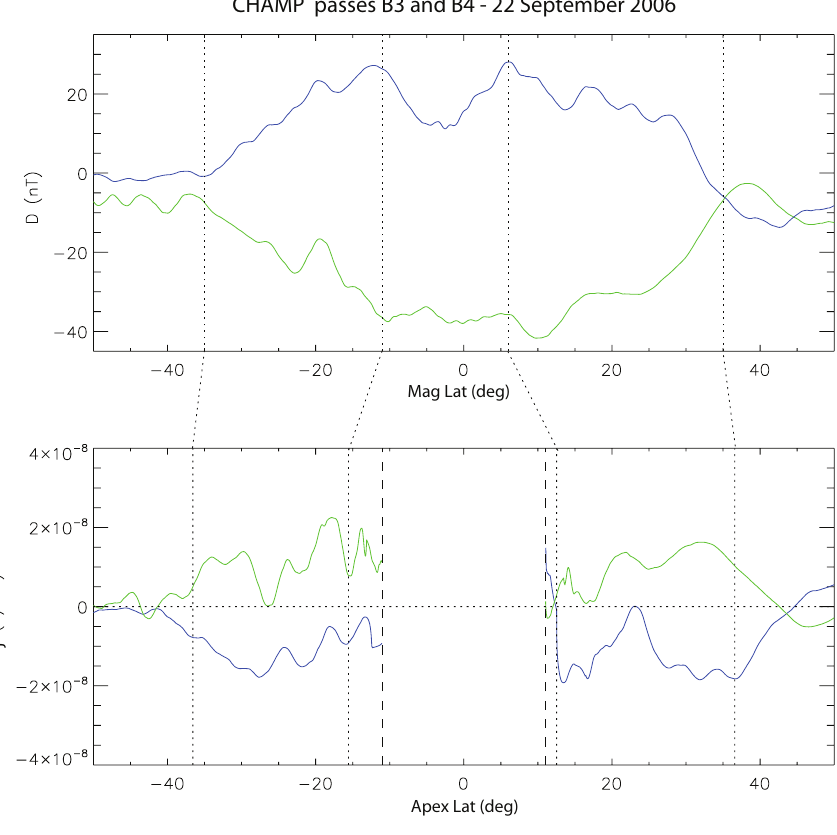
Fig. 5. Variation of the D component (top) and corresponding field-aligned current density at E-layer altitude (bottom) for the latitude range of interest (dotted lines), for the 22 September 2006 solar eclipse. The unsampled E-region latitude gap is indicated by the dashed